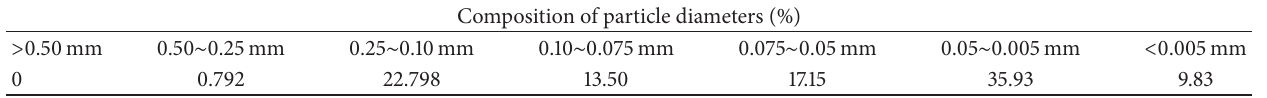
Table 1: Basic physical parameters of